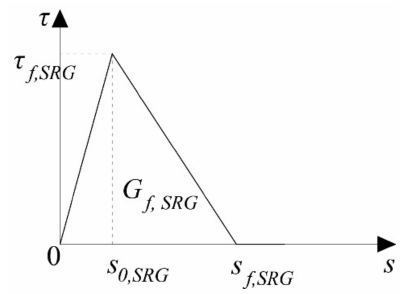
Figure 5. Interface